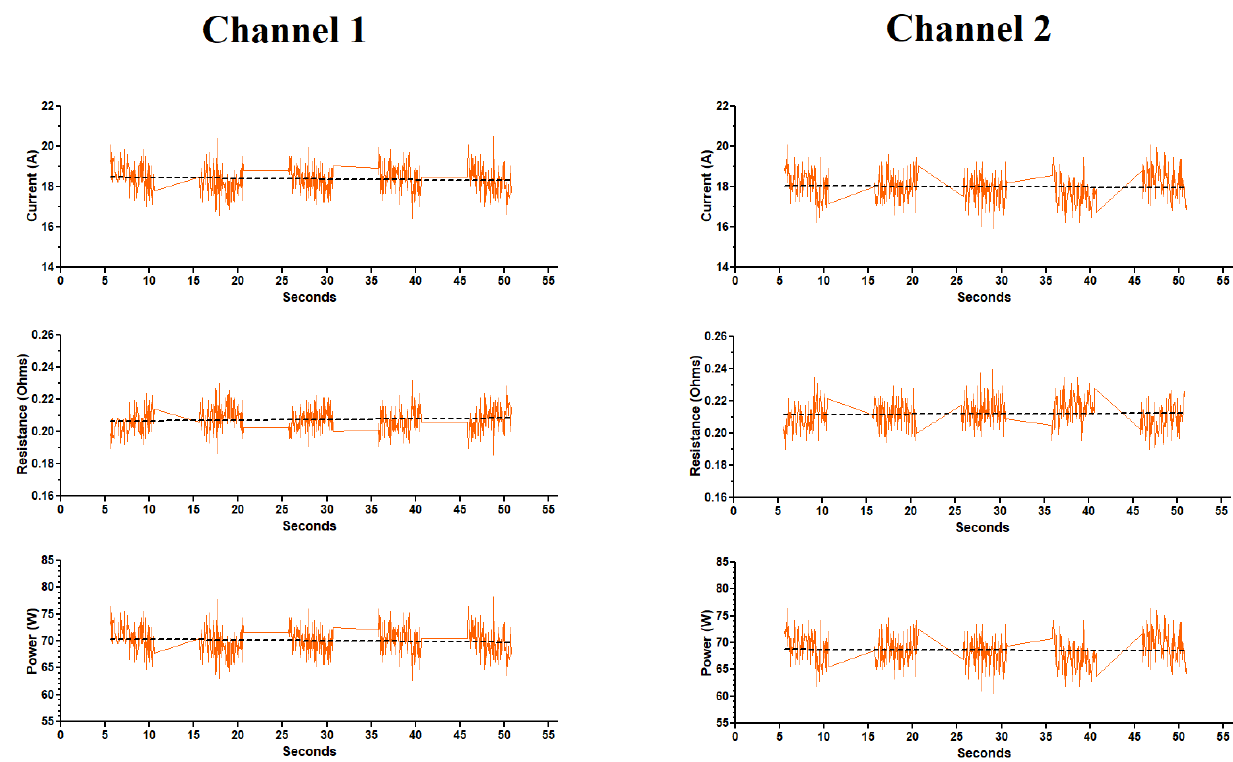
Figure 4. Temperature profiles (orange = inside temperature and blue = outside temperature) for two E-liquid atomizers running simultaneously on two channels for 75 min (or 300 puffs). Table 1. Temperature Profiles.